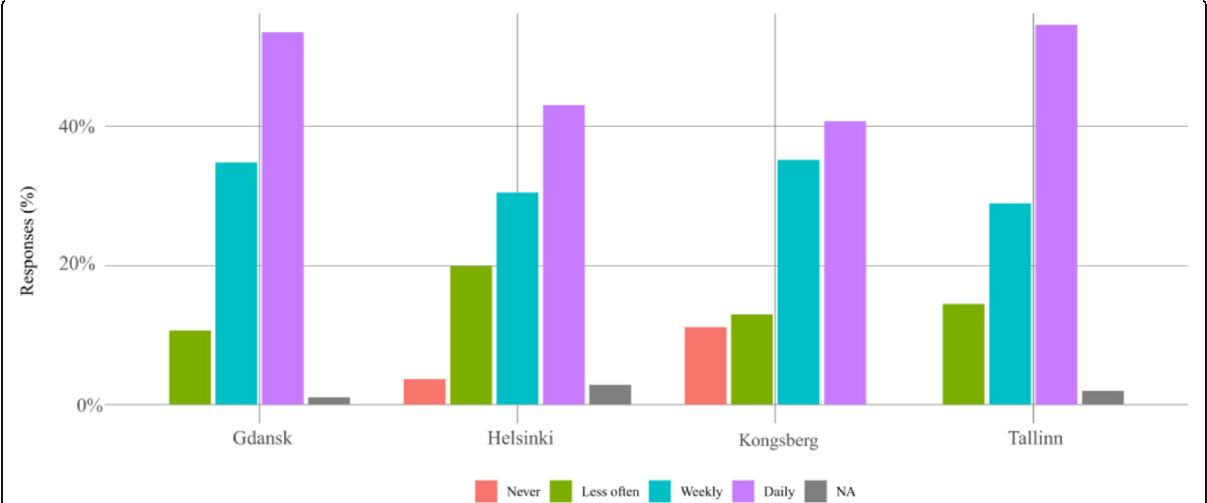
Fig. 5 Distribution of answers to question n. 7 in Additional file 1, studying how often people would use the autonomous bus shuttle if it was available for daily commuting